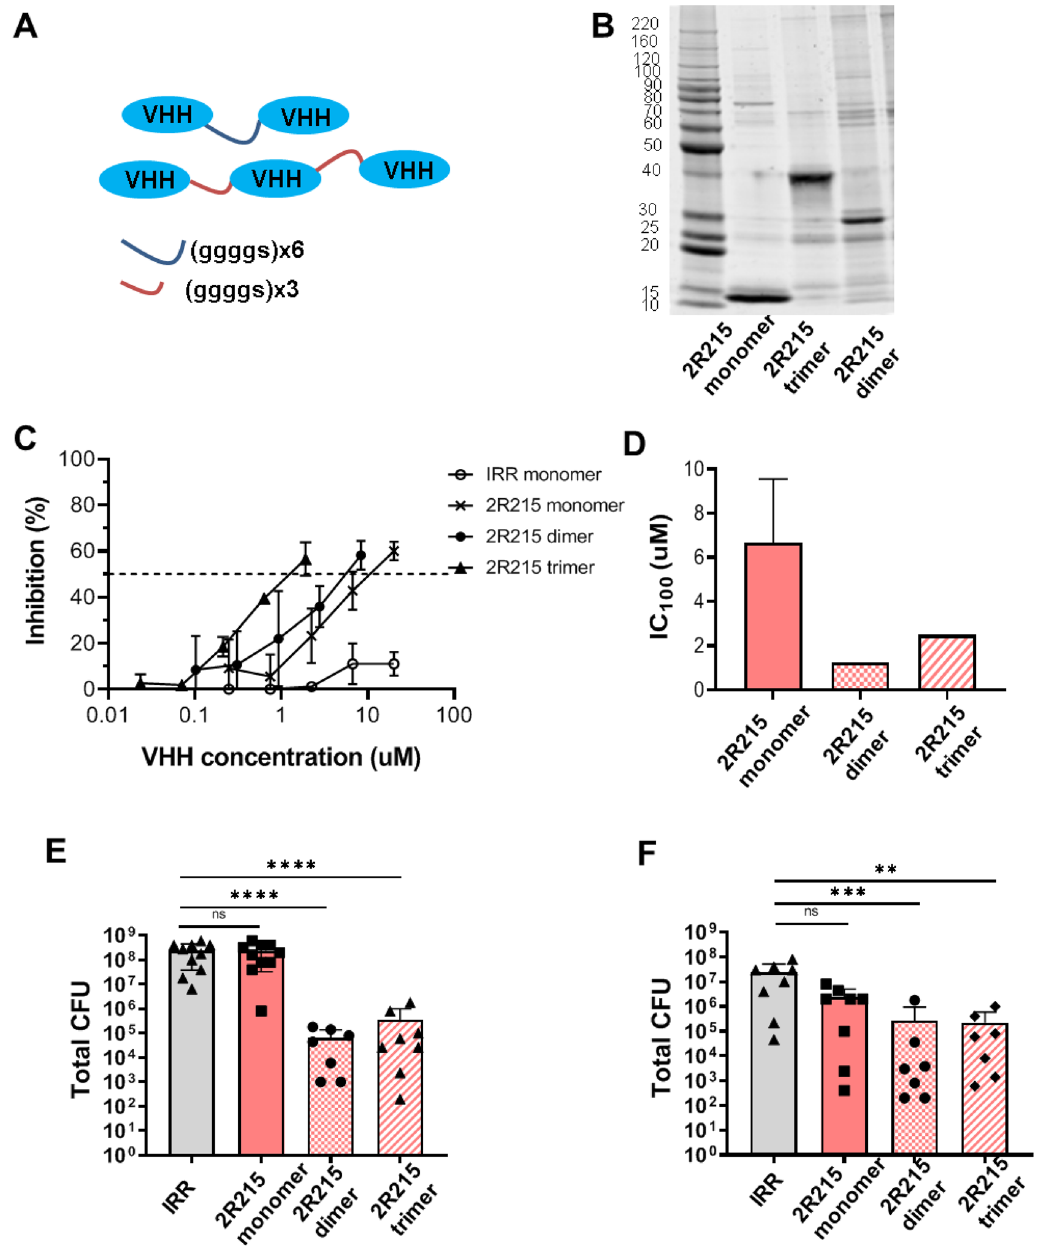
Figure 4. Multimerization enhances the potency of 2R215 in vitro and in vivo. ( A ) Cartoon representation of multimerization strategy. VHH 2R215 was engineered as a dimer or trimer molecules using 3 × or 6 × (G4S) linkers in tandem N to C terminus orientation. ( B ) Multimerized nanobodies were expressed in bacteria and purified using fused His tags. Purified multimer sizes were verified by polyacrylamide gel electrophoresis. ( C ) Dimeric and trimeric 2R215 show increased potency in Caco2 cell adhesion assays. The IC 50 values are 10.213 µM for monomeric 2R215, 5.09 µM for dimeric 2R215 and 1.06 µM for trimeric form of 2R215. Three biological replicates were performed ( P < 0.05 and P < 0.01 for dimeric and trimeric forms compared to monomeric forms respectively. P > 0.05 when dimeric was compared to trimeric format). ( D ) Activity in the MRHA assay is improved with an IC 100 of 6.7 µM for monomeric, 1.25 for dimeric and 2.5 for the trimeric form of 2R215. Three biological replicates were performed. ( P < 0.01 and P < 0.05 for dimeric and trimeric forms compared to monomeric forms respectively. P > 0.05 when dimeric was compared to trimeric format). ( E ) Mice inoculated with ETEC pre-incubated with 10 mg/kg of dimeric or trimeric forms of 2R215 showed a log reduction of 3.5 and 2.8 in colonization ( P < 0.0001) compared to the monomeric 2R215 treated group at the same dose. Two biological replicates were performed. ( F ) The dimeric and trimeric forms of 2R215 retained their activity when administered 2 h prior to bacteria challenge as compared to the monomeric form. Pre-treatment with dimeric and trimeric 2R25 reduced total CFUs by 1.9 log ( P < 0.001) and 2 log ( P < 0.01) respectively. Two biological replicates were